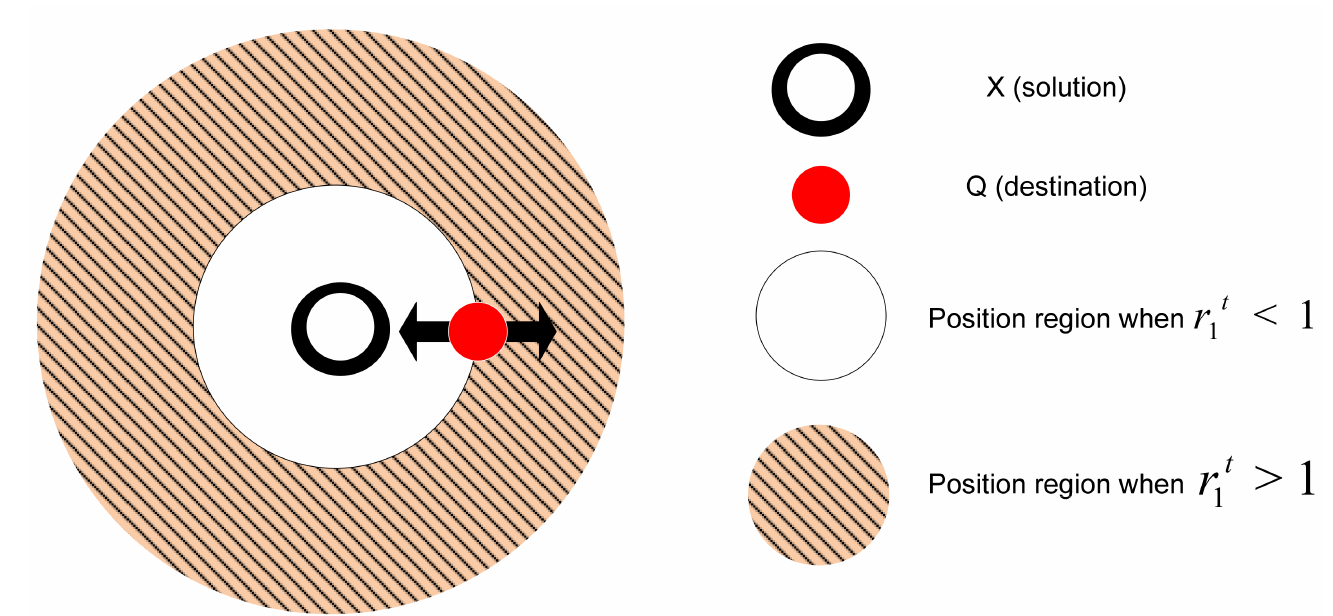
Figure 4. Effects of sine cosine in Equations (50) and (51) on the upcoming locality.